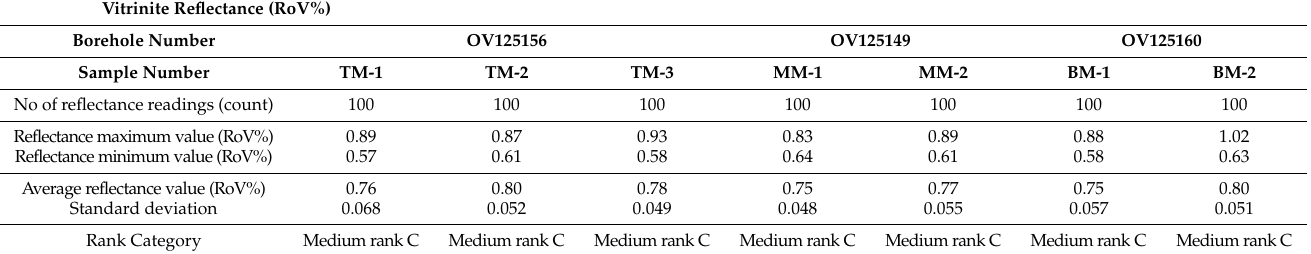
Table 4. Interpretation of the vitrinite reactance values for the analyzed coal samples.